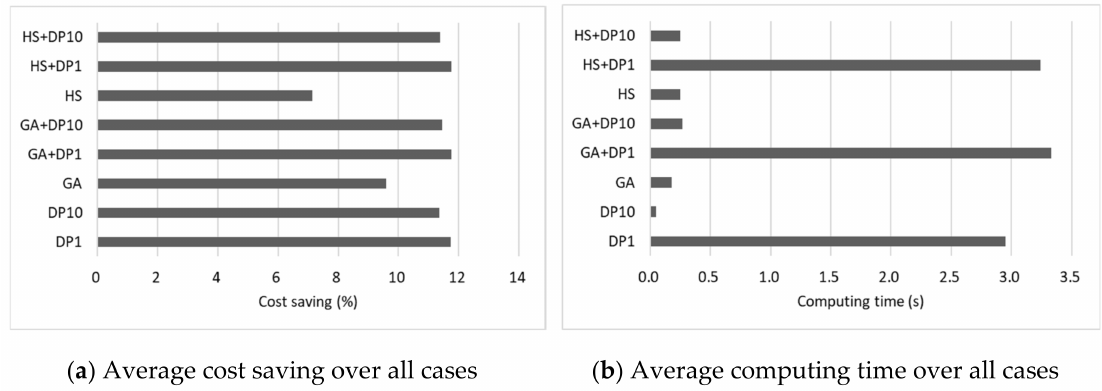
Figure 4. Average cost savings and computing times of the proposed methods without demand